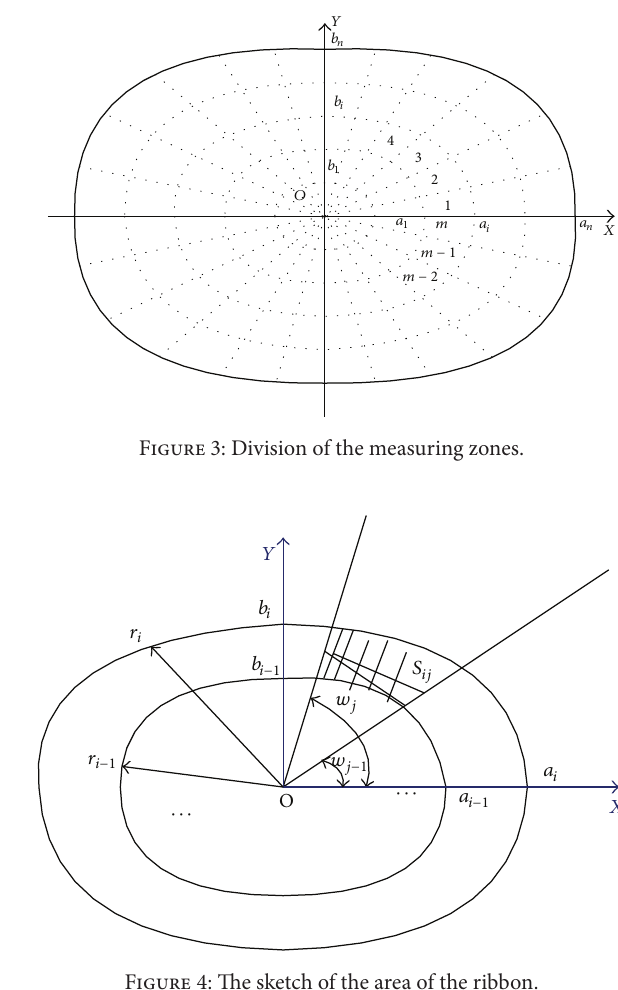
Figure 4: The sketch of the area of the